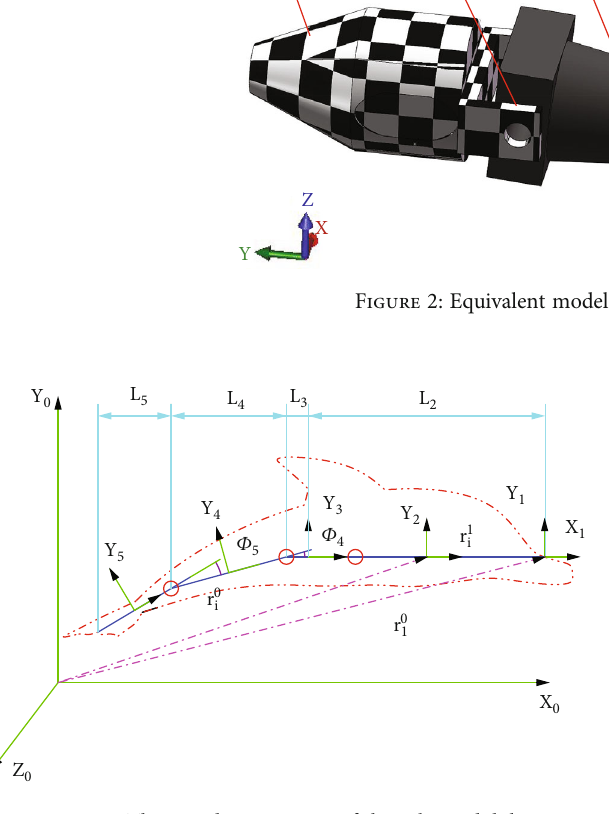
Figure 3: The coordinate system of the robotic